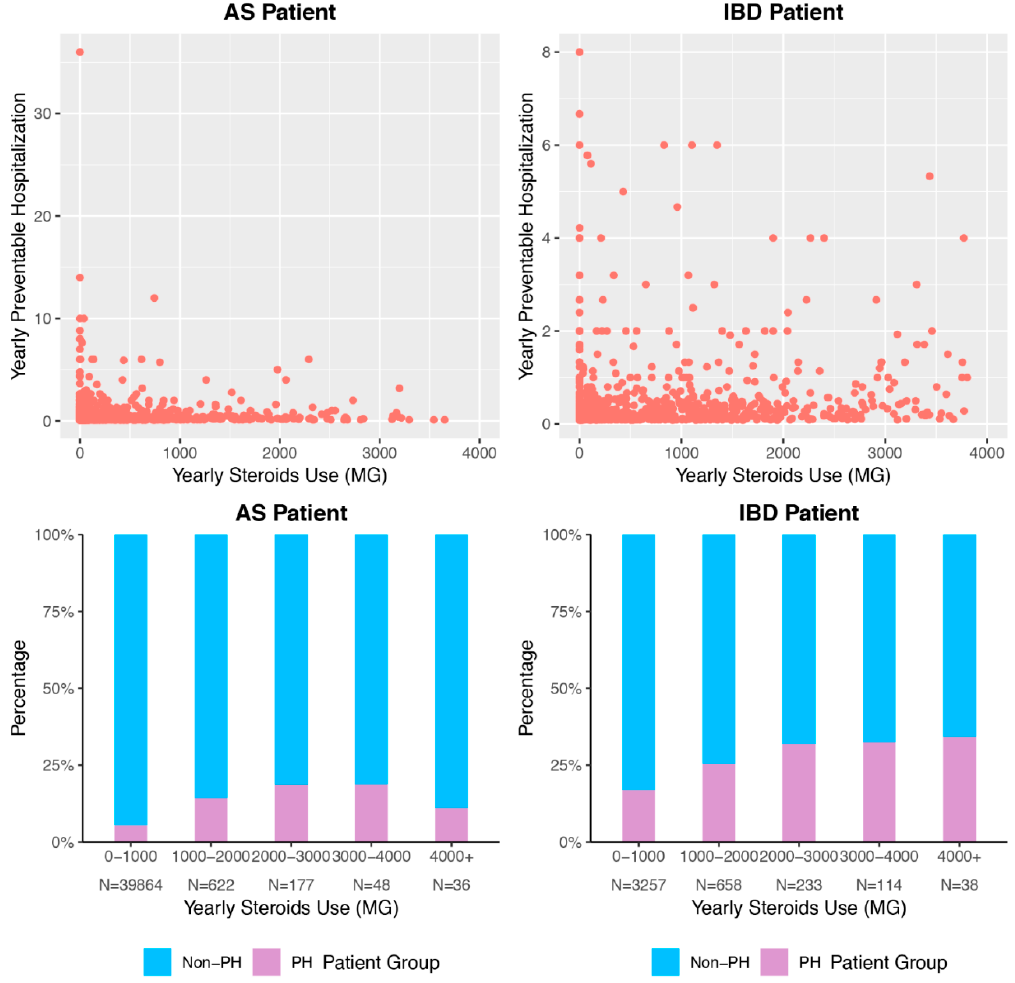
Figure 1. Association of Cumulative Steroid Exposure and Preventable Hospitalization. Density of points describes marginal association between cumulative corticosteroid dose and cumulative hospitalizations for ambulatory care-sensitive conditions. Bar graphs indicate percentage of patients per corticosteroid dose range who experience at least one hospitalization for ambulatory care-sensitive conditions during the study period. PH = preventable hospitalization, meaning hospitalization for ambulatory care-sensitive condition. AS = ankylosing spondylitis. IBD = inflammatory bowel disease